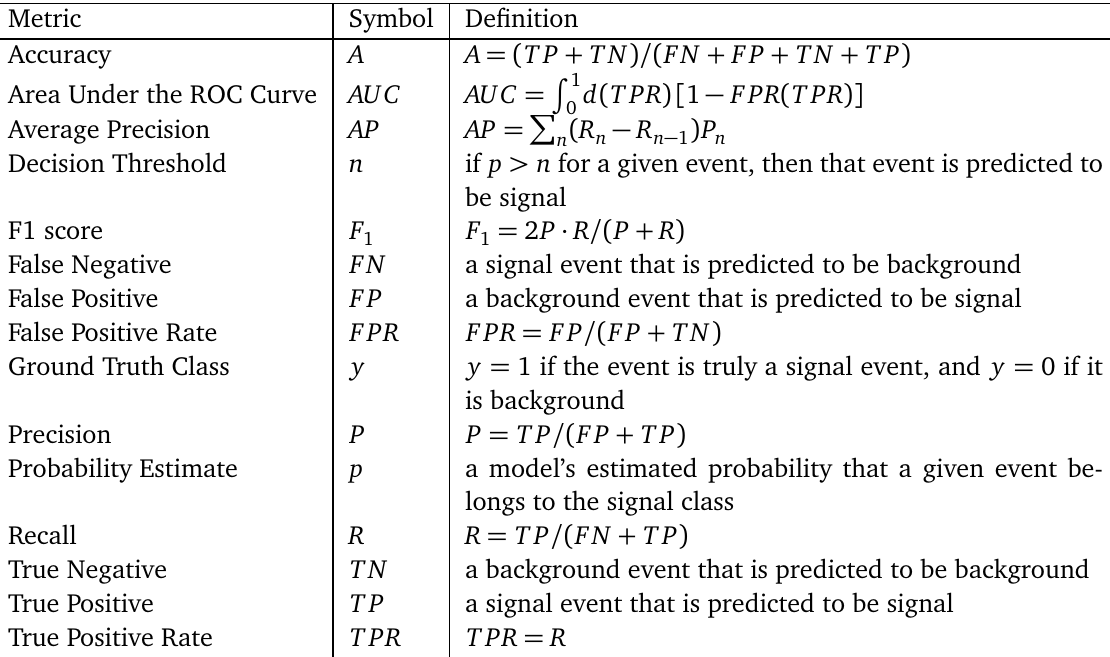
Table 3: Glossary of model evaluation terms used in this